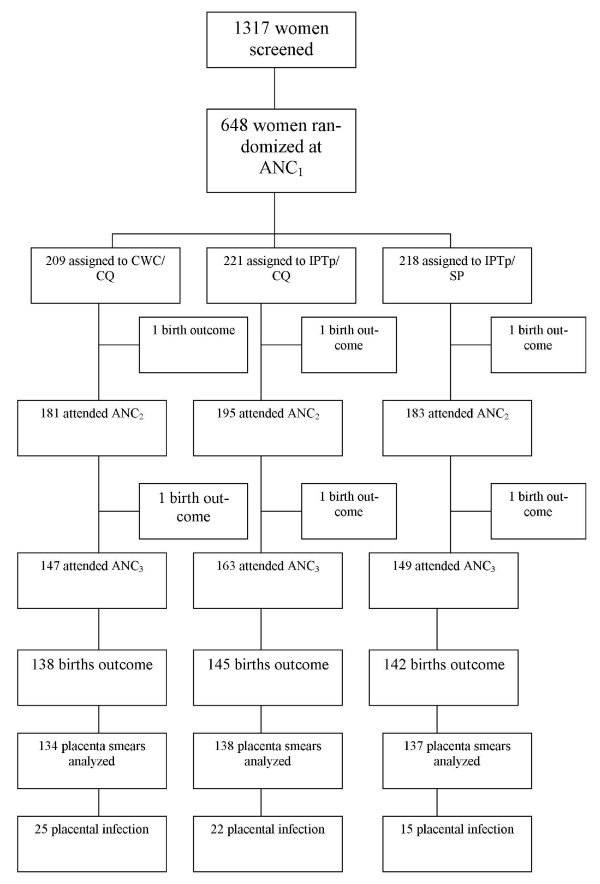
The trial profile.